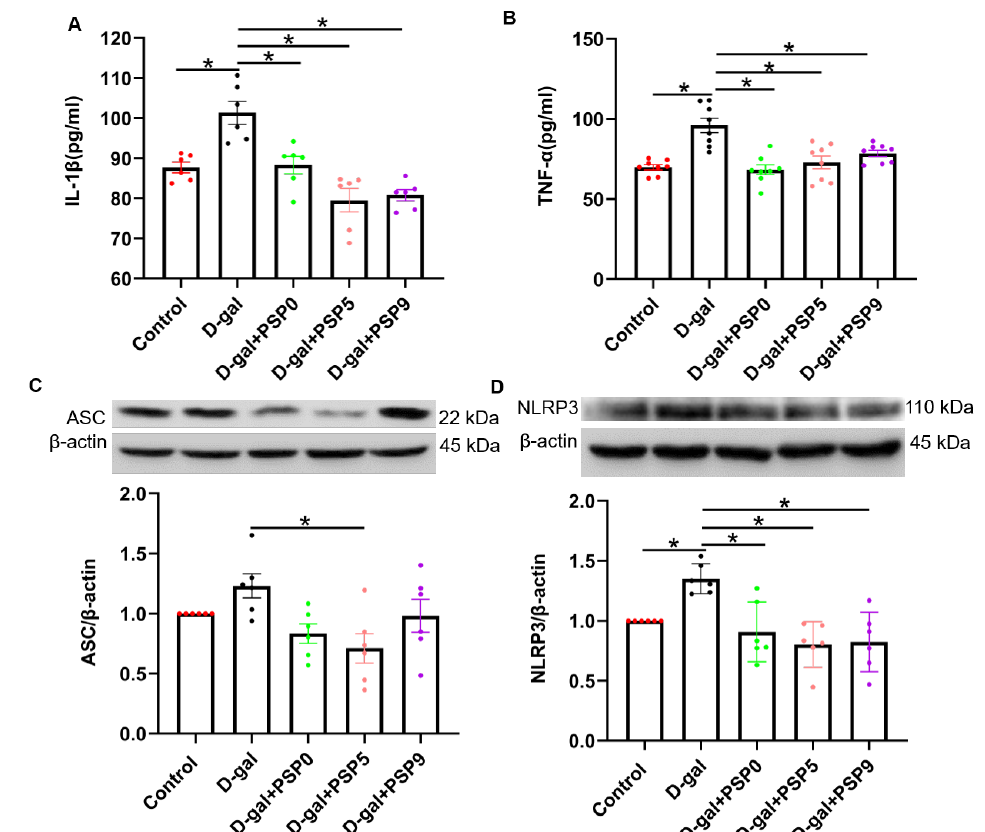
Figure 6. Steamed PSPs inhibit D-gal-induced neuroinflammation. ( A , B ) TNF- α and IL-1 β levels in the serum ( n = 6–8). ( C , D ) The upper panels show representative blots of ASC/ β -actin and NLRP3/ β -actin, while the lower panel shows ASC/ β -actin and NLRP3/ β -actin quantification data ( n = 6). Data are expressed as means ± SEM. * p < 0.05.